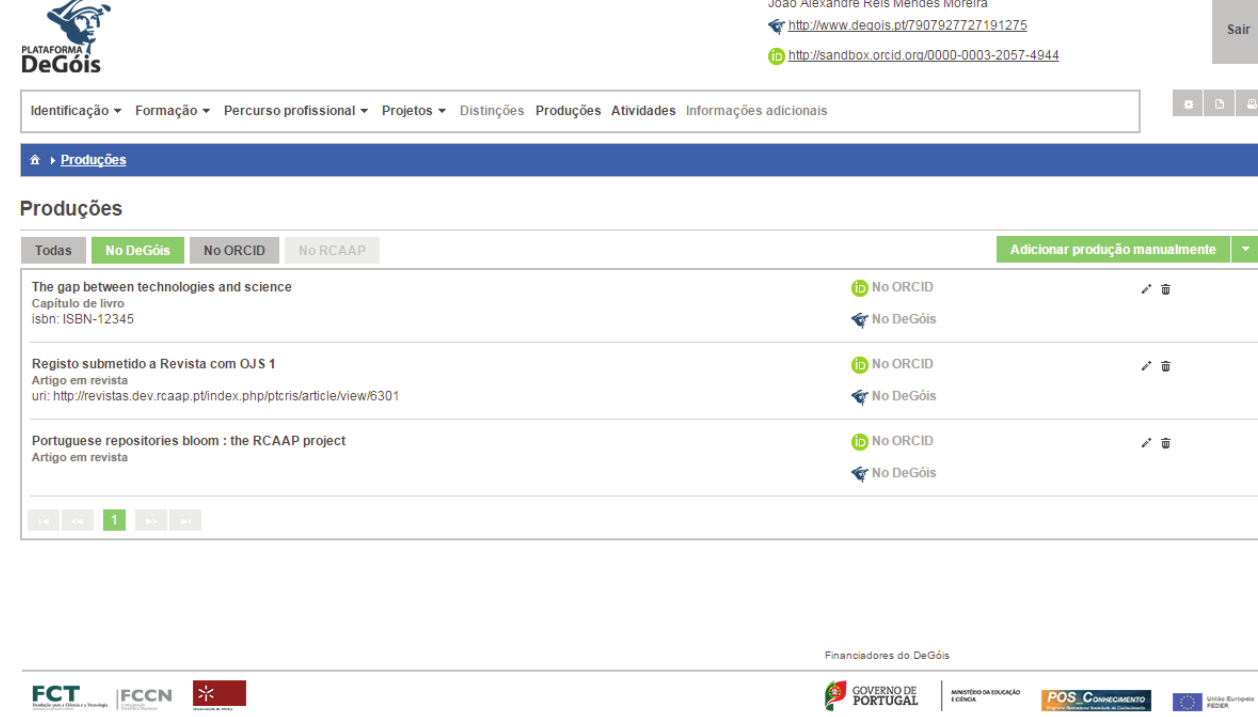
Figure 10. User profile at